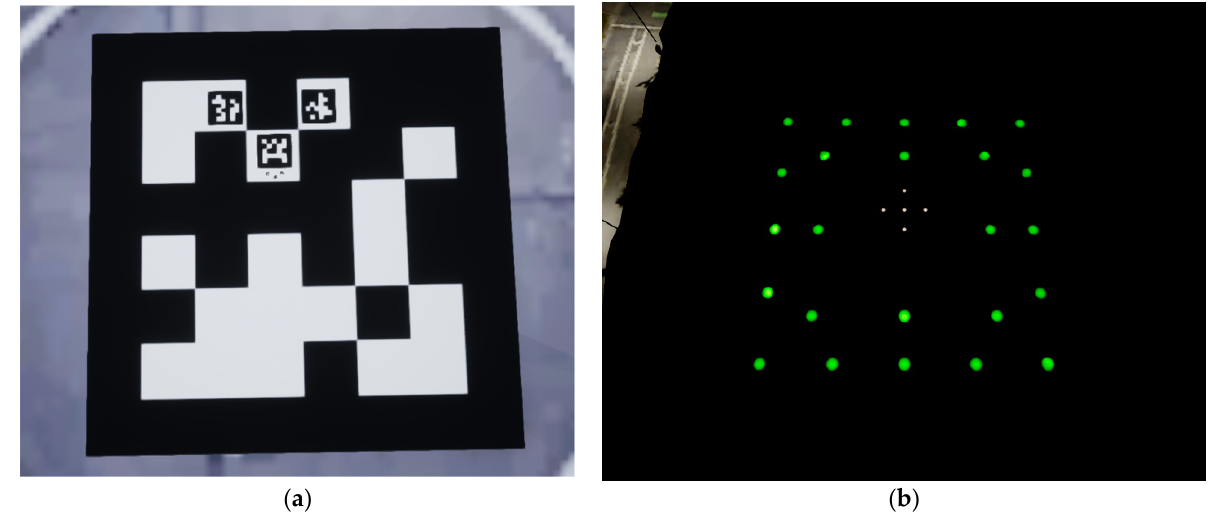
Figure 6. ( a ) AprilTag markers configuration; ( b ) Lights